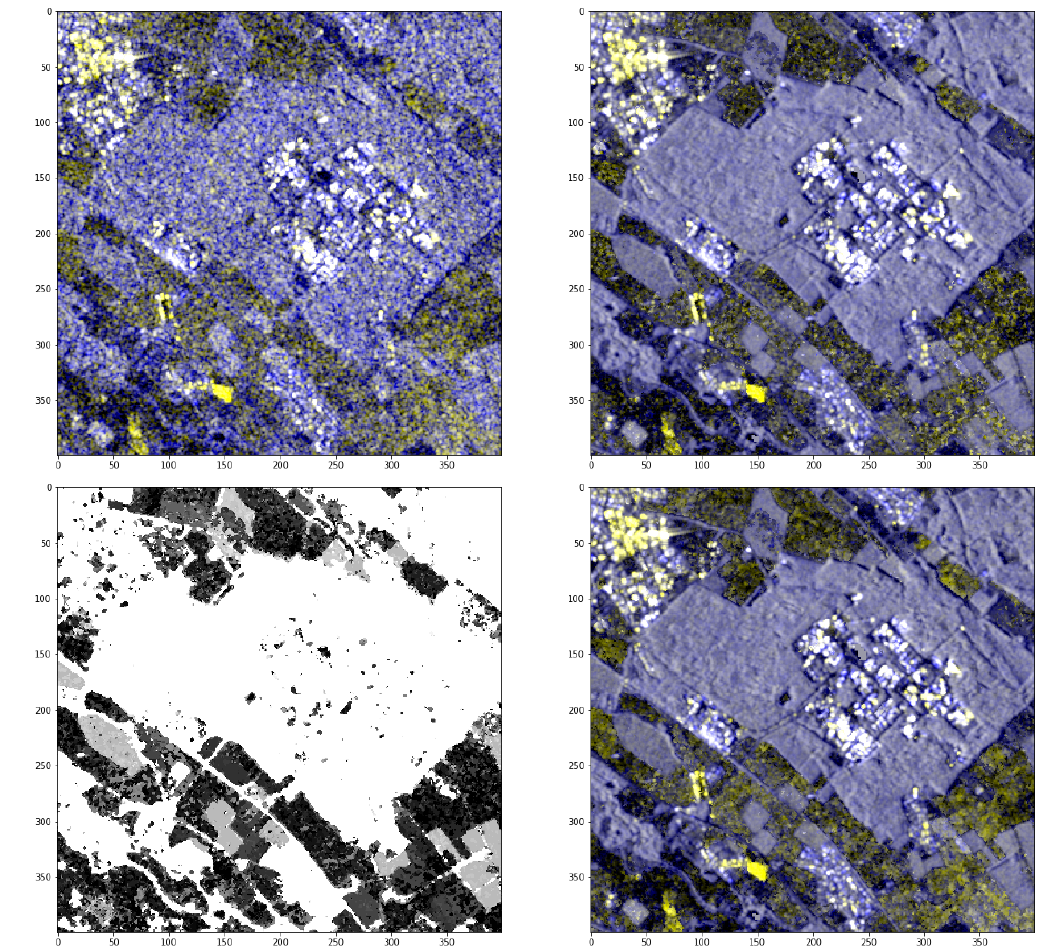
Figure 3. Comparison of the original image ( top left ) and ATSF ( top right ) for a small spatial subset of the reference image of Figure 1. Bottom left: the number of images used in forming the ATSF, black = 1, white = 29. Bottom right: the thresholded